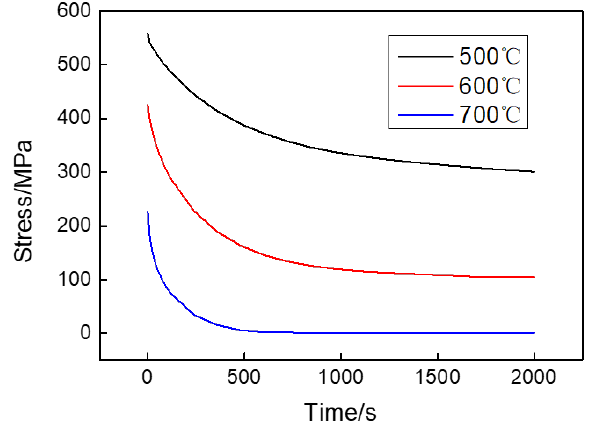
Figure 6. Stress relaxation curves of creep specimens.